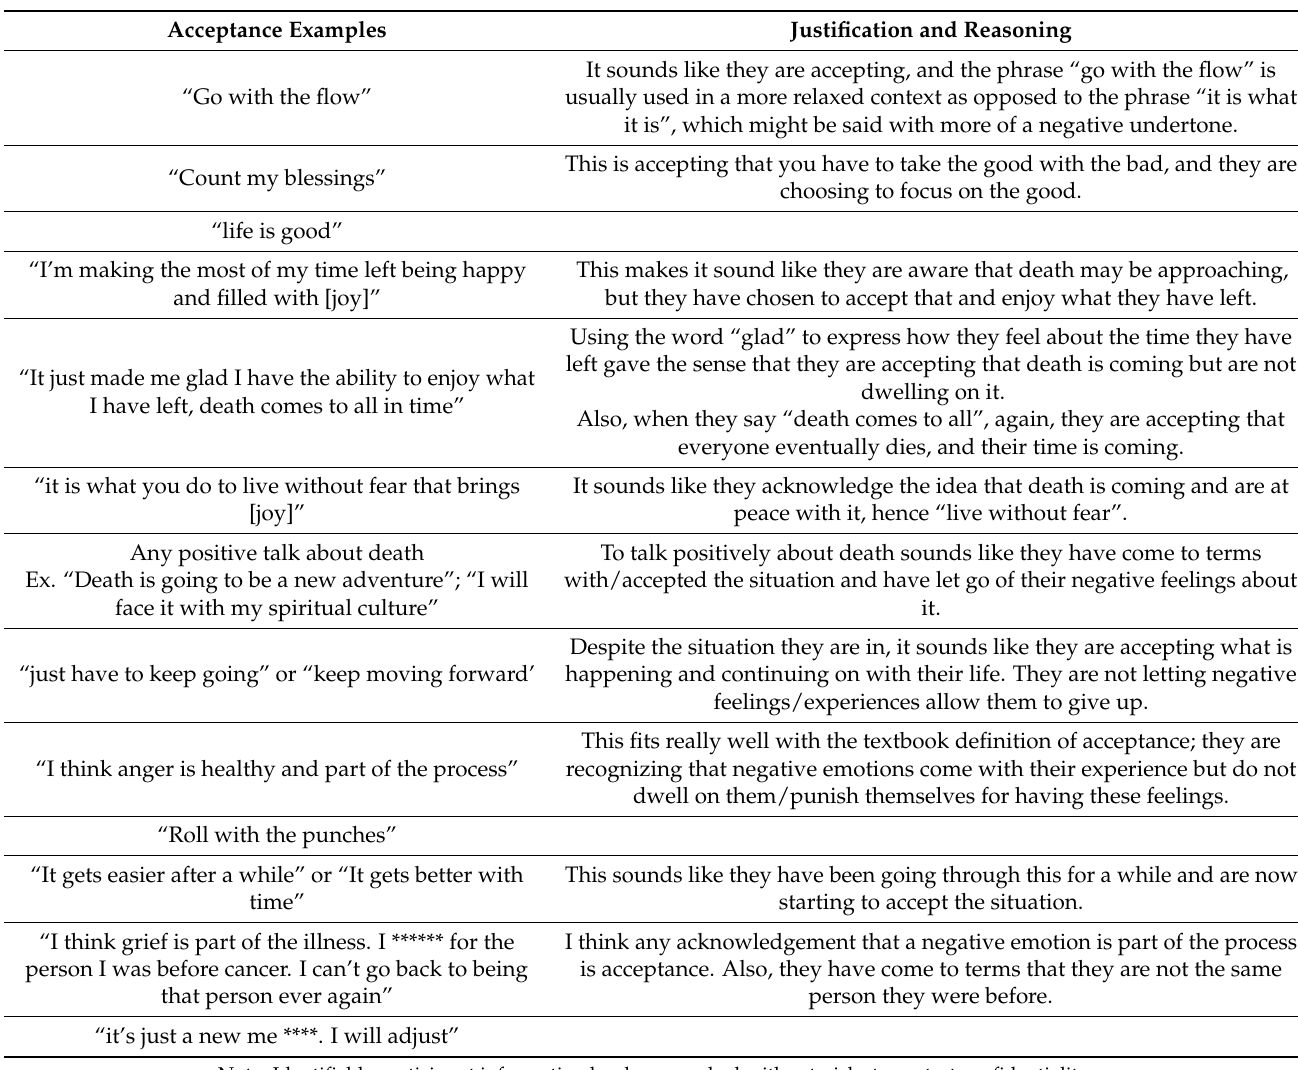
Table A1. Acceptance Examples. Examples of acceptance-related quotes identified prior to analysis with author’s corre- sponding justification and reasoning as to why these quotes indicated acceptance.